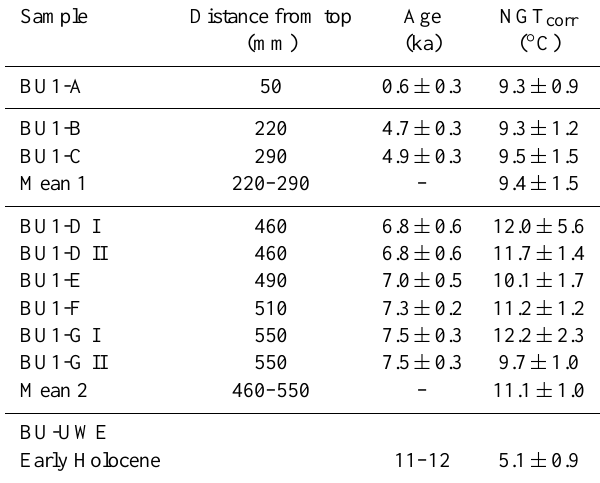
Table 3. Noble gas temperatures in stalagmites BU-UWE (Kluge et al., 2008) and BU1. The temperatures (NGT corr ) have been cor- rected using a constant offset by comparison with the multi-proxy temperature reconstruction of Mann et al. (2008). Noble gas con- centrations and evaluation parameters are given in the Supplement. Mean 1 is the average value of BU1-B and BU1-C used for co- variation reconstruction of sample BU1-5, mean 2 is the average of BU1-DI to BU1-G II used for BU1-8 and BU1-9.